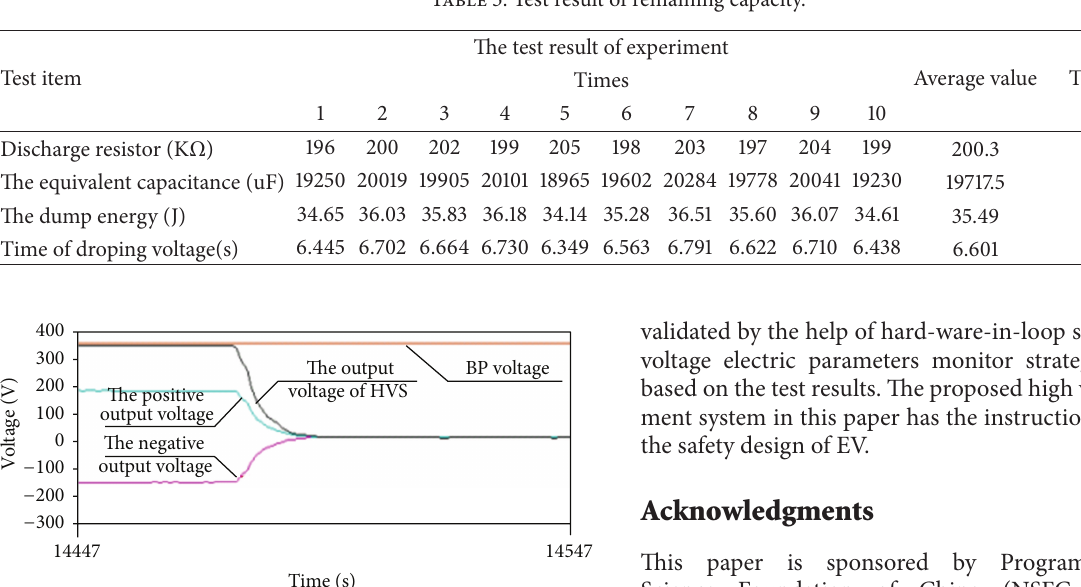
Table 3: Test result of remaining capacity.